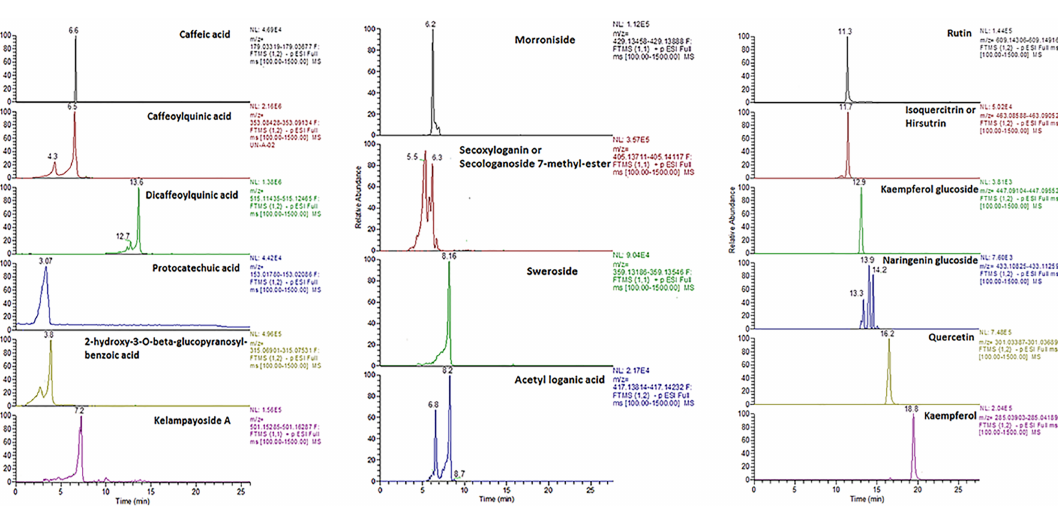
PLOS ONE | https://doi.org/10.1371/journal.pone.0202415 August 17,